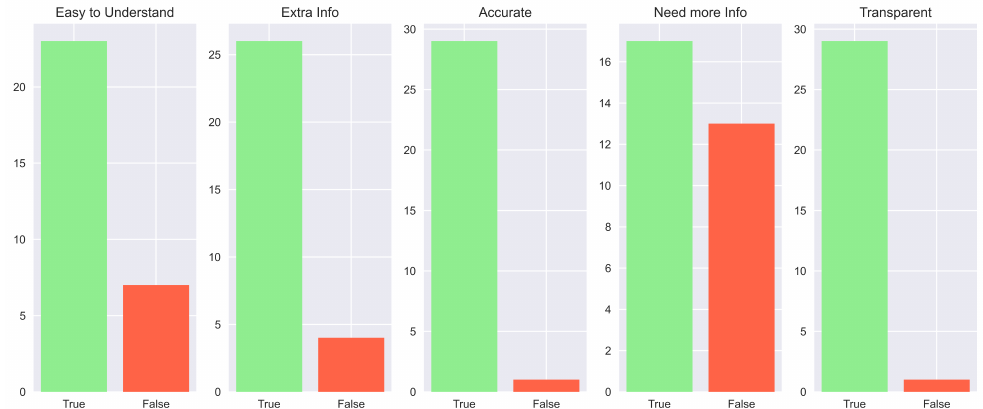
Figure 21. Bar charts representing the results of the True and False statements for different aspects of the actual